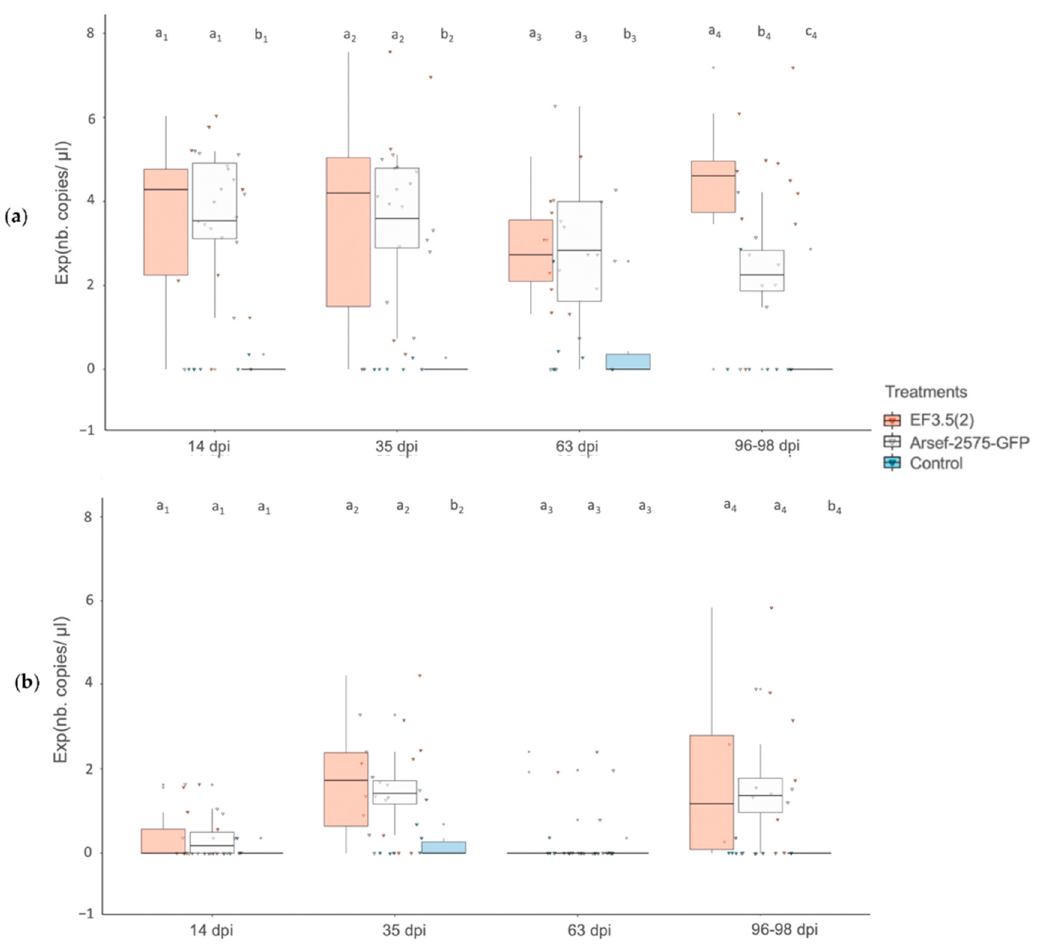
Figure 1. ( a ) Time-course of quantification of rhizospheric V. vinifera association of two M. robertsii strains (EF3.5(2), red boxes; GFP transformed strain ARSEF-2575-GFP, white boxes) and a control treatment (blue boxes) using ddPCR. The boxplots represent the logarithm of the number (nb) of DNA copies (of non-null values) of M. robertsii per microliter of DNA extracted of mixed non-disinfected grapevine roots with adhering soil (rhizosphere) 14-, 35-, 63- and 96–98 days post inoculation (dpi). Significant differences are indicated by small letters above to boxes (Kruskal–Wallis test, p < 0.05); ( b ) Time-course of quantification of endophytic V. vinifera root association of two M. robertsii strains using ddPCR. The boxplots represent the logarithm of the number (nb) of DNA copies (of non-null values) of M. robertsii per microliter of DNA extracted of mixed disinfected grapevine roots